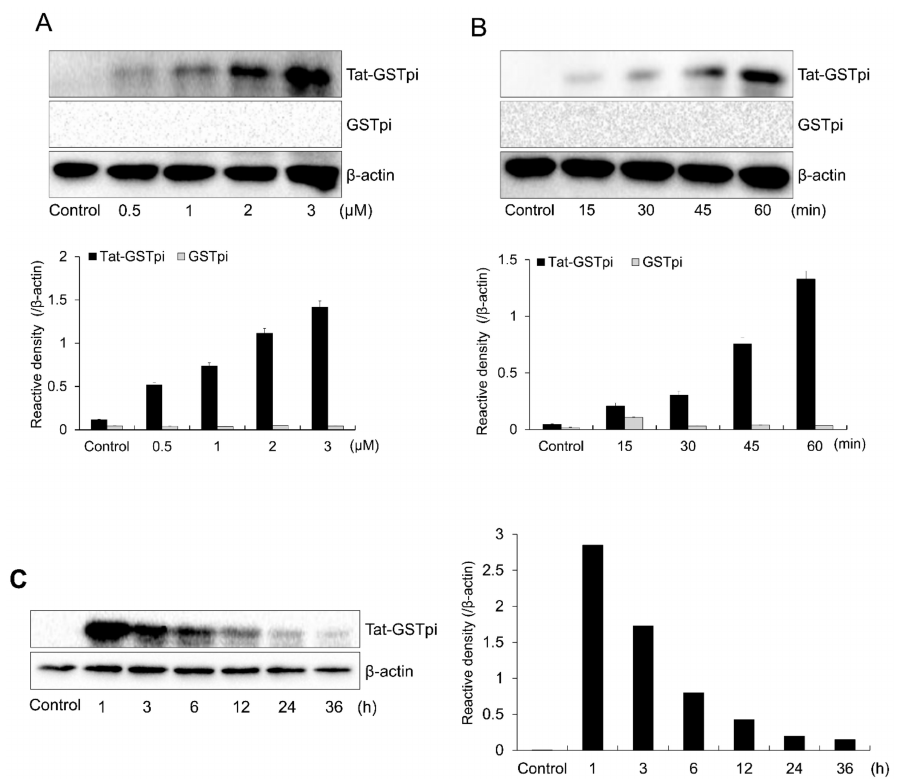
Figure 2. Delivery of Tat-GSTpi protein to SH-SY5Y cells. ( A ) SH-SY5Y cells culture media were treated with Tat-GSTpi or GSTpi protein at different doses (0.5–3 µ M) for 1 h; ( B ) The cell culture media were treated with Tat-GSTpi (3 µ M) or GSTpi protein for different time periods (15–60 min); ( C ) Intracellular stability of delivered Tat-GSTpi protein. The cell culture media were incubated for 36 h after delivery of Tat-GSTpi protein for 1 h. Then, Tat-GSTpi protein was detected by Western blotting and the intensity of the bands was measured by a densitometer. Data are represented as mean ± SEM ( n =